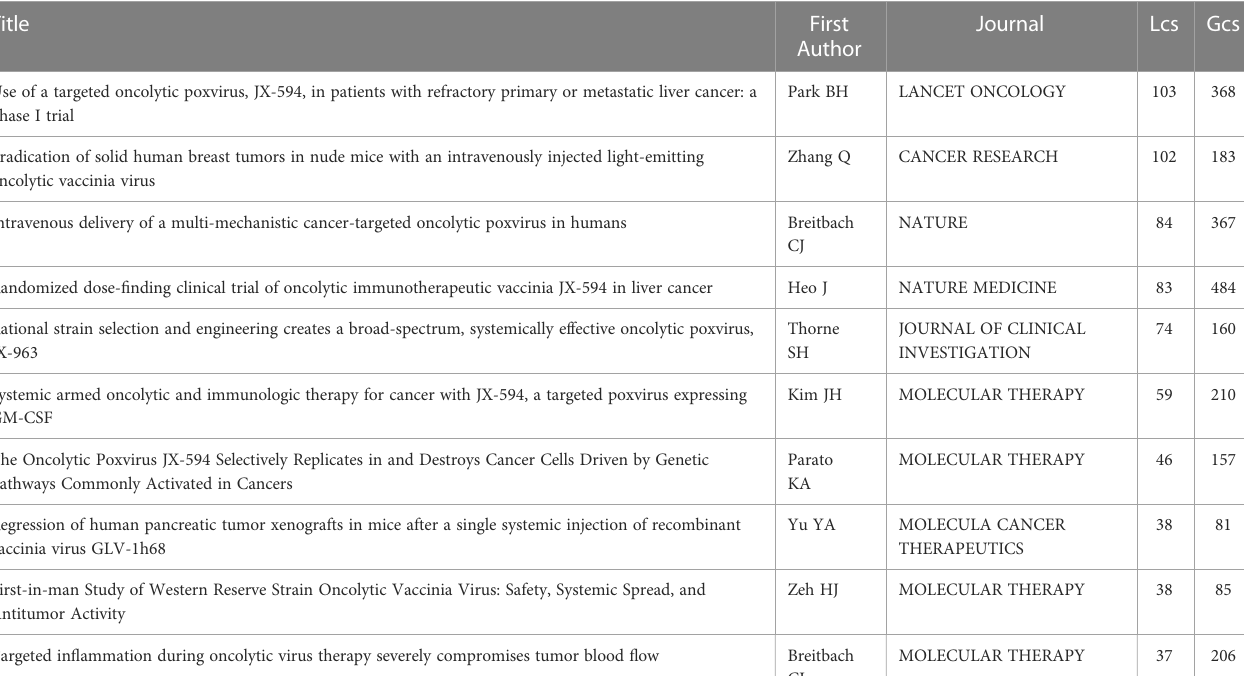
TABLE 1 The relevant information for the top ten items of literature ranked by